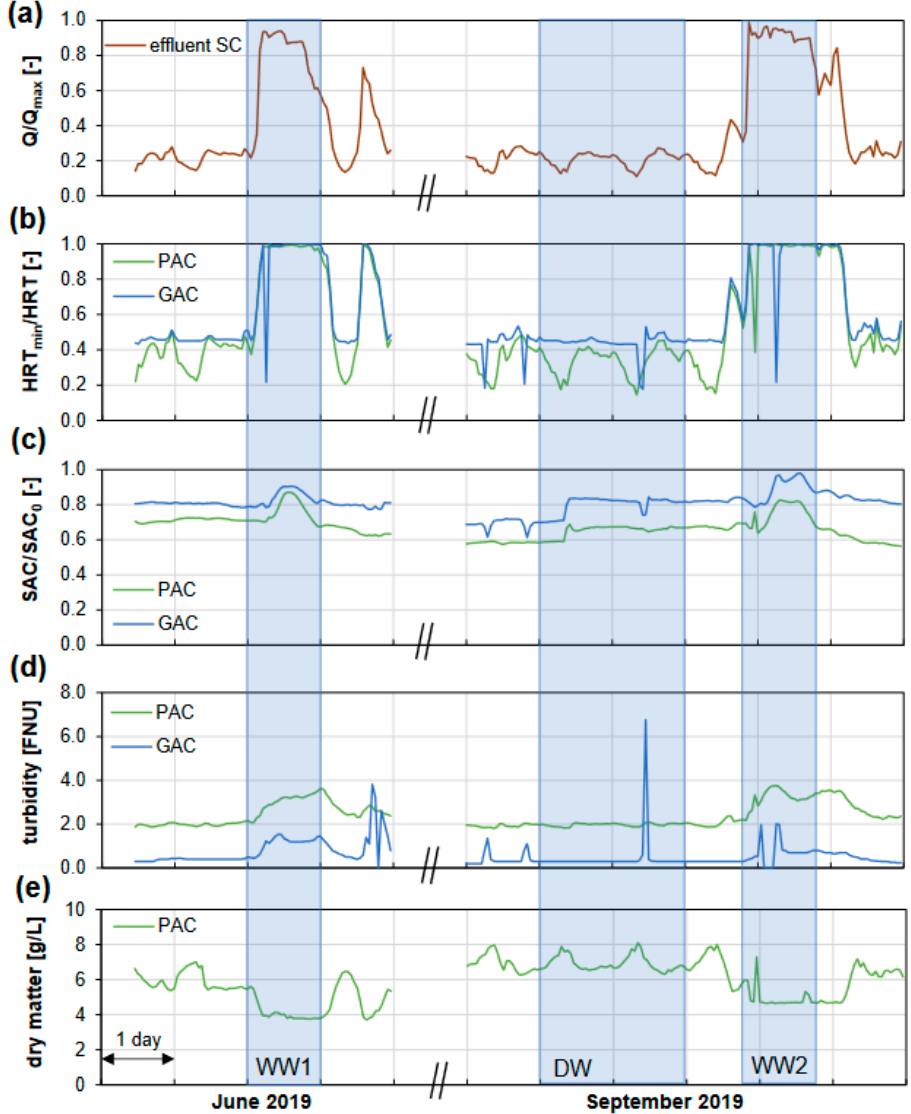
Figure 2. Conditions during WW and DW samplings performed in June and September 2019: ( a ) Q/Q max as an indicator for the dilution (Q max = 4000 L/s); ( b ) ratio of HRT min /HRT for both additional treatment stages with activated carbon; ( c ) removal of SAC 254 for PAC and GAC; ( d ) course of the turbidity for PAC and GAC; and ( e ) dry matter content in the PAC treatment.